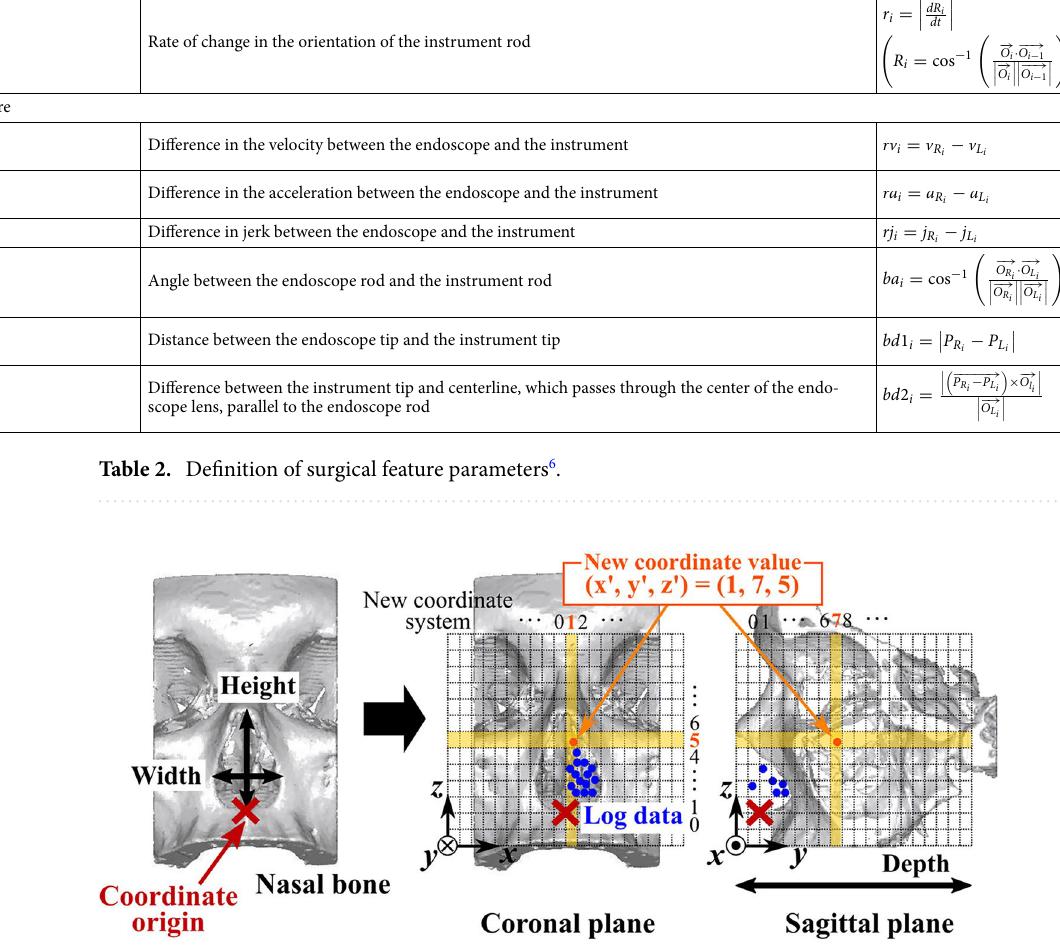
Figure 2. Assignment of the new coordinate values to the surgical log data 7 . Based on the size of the nostrils of the patient, the coordinate system is set so that the number of blocks (i.e., voxels) of the new coordinate system is matched with the nasal cavity in each patient. In the new coordinate system, the coordinates are set for the left and right nasal cavities so that they are symmetrical with respect to the nasal septum. Moreover, the same coordinate value is obtained, regardless of which nasal cavity is